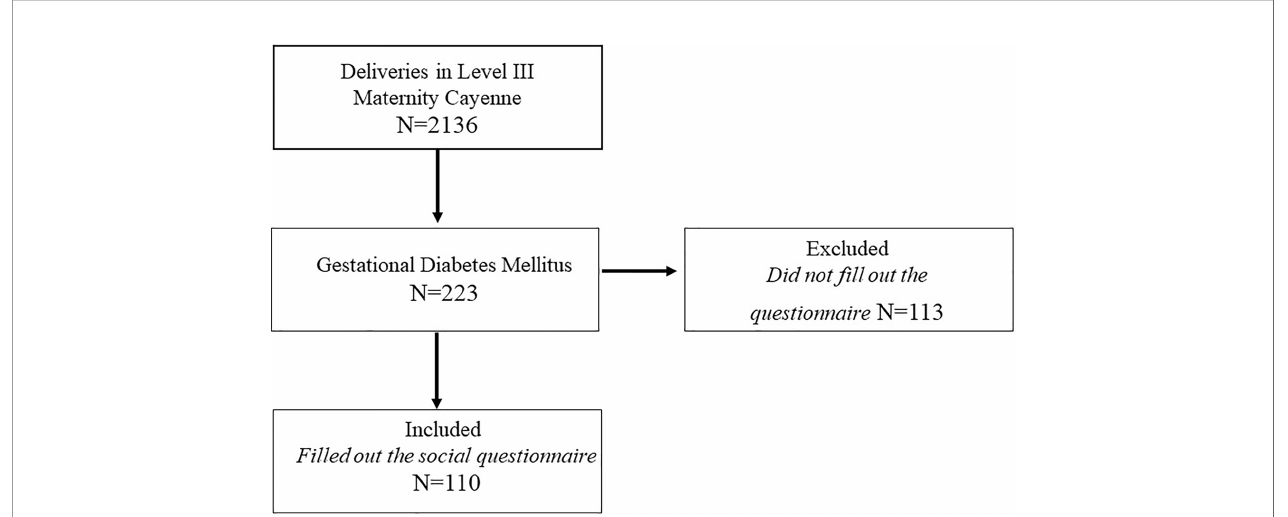
FIGURE 1 | Flow-chart Gestational Diabetes Mellitus patients included during the study